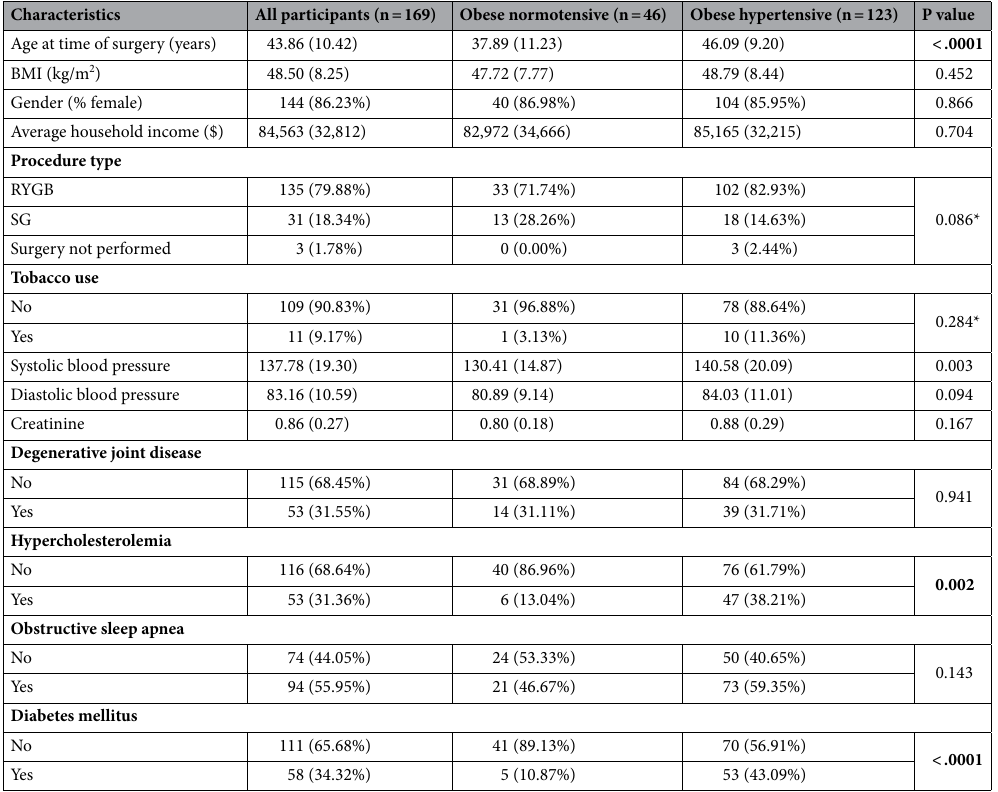
Table 1. Baseline characteristics of obese normotensive versus obese hypertensive patients. BMI = Body Mass Index (Weight/Height 2 ); Data are expressed as mean (standard deviation) if numerical variables, or as the number of patients and their percentages (%), if categorical; *Fisher Exact Test; Hypertension in obese: (1) Patient reported having hypertension and/or required medication at the time of screening; (2) the patient had a systolic blood level ≥ 140 mmHg and/or diastolic levels ≥ 90